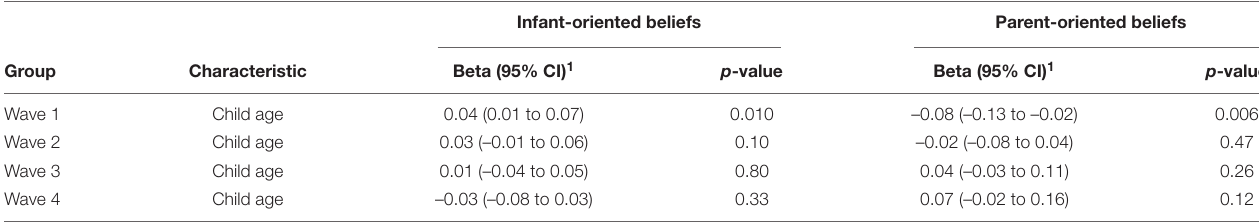
TABLE 2 | Results of regression analysis predicting infant crying questionnaire (ICQ) from child age in each wave. Infant-oriented